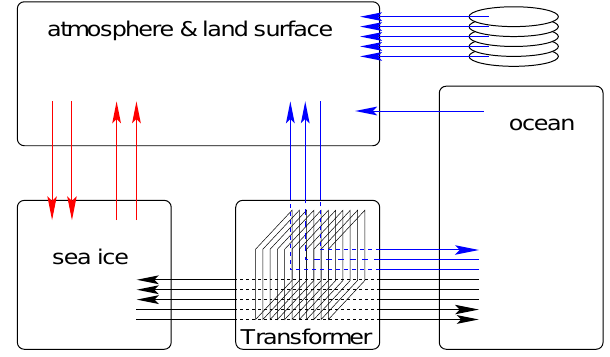
Fig. 9. Example of communication pathways in an OASIS4 coupled